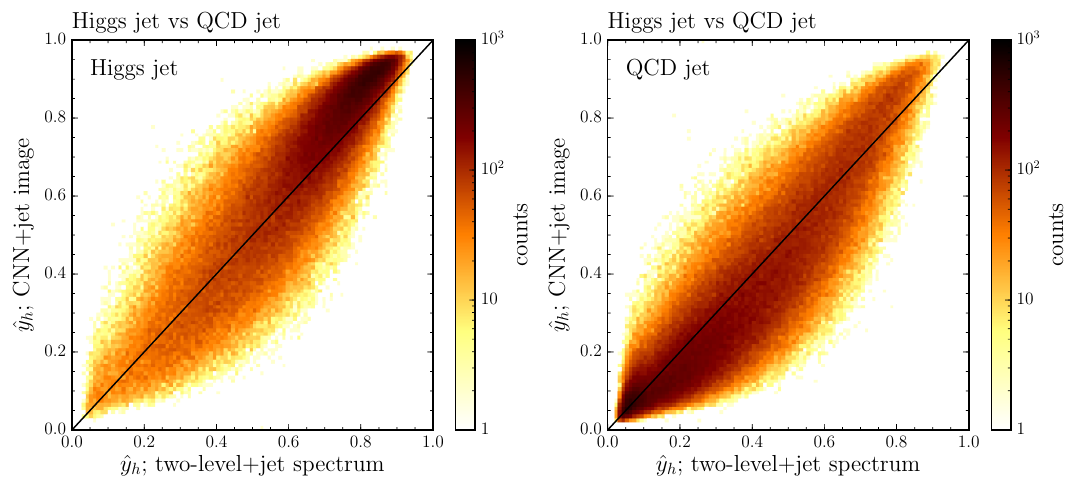
Figure 13 . Two-dimensional histograms of two ^ y h ’s from the two-level architecture and the jet image CNN in Higgs jet vs. QCD jet classi(cid:12)cation. The left panel is the histogram of Higgs jets, and the right panel is that of QCD